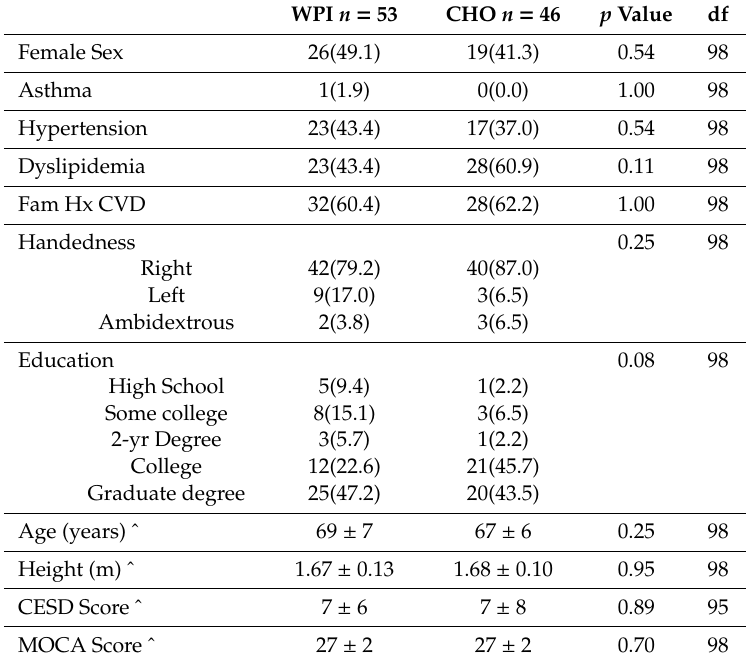
Figure 1. Participant exclusion criteria and recruitment/enrollment flow chart. MI, myocardial infarction; mo, months; yrs, years; GI, gastrointestinal. Table 1. Descriptive characteristics ( n (%), unless otherwise noted).